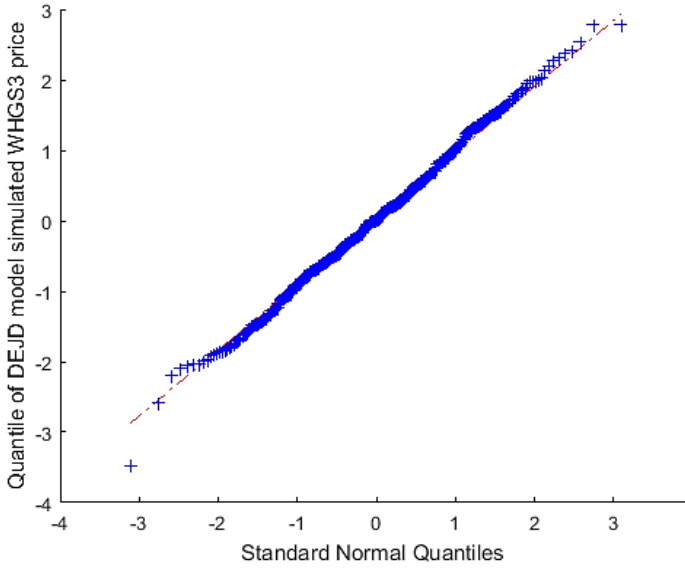
Figure 7. The Q-Q plot of DEJD model simulated WHGS3 sesame